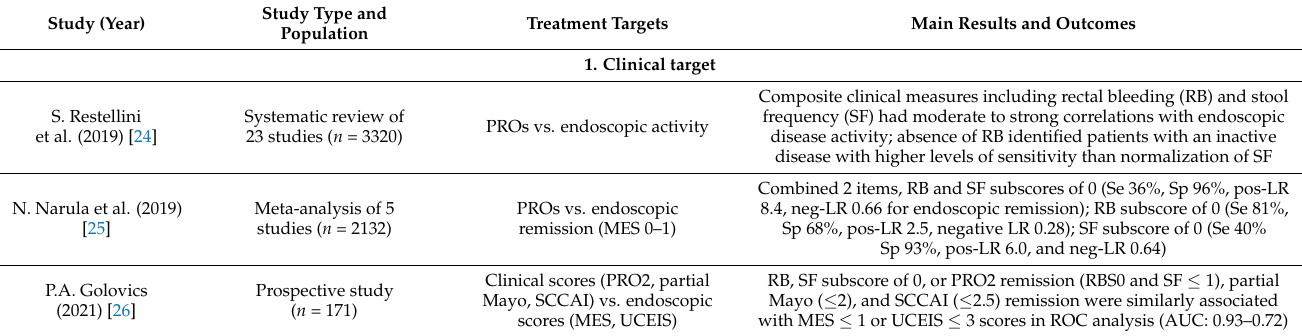
Table 3. The selected current studies of clinical, biomarker, endoscopic, and histological targets in the treatment of patients with